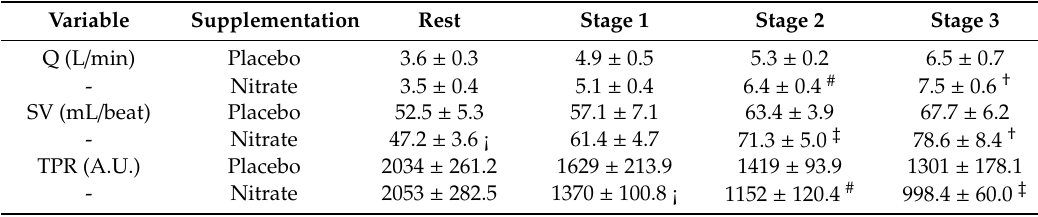
Figure 2. Individual and mean responses of plasma nitrate ( A ) and plasma nitrite ( B ). Black boxes are the nitrate treatment and the white circles represent placebo treatment. Abbreviations: NO 3- , nitrate, NO 2- , nitrite, * indicates significance at p < 0.05, ** indicates significance at p < 0.01. Table 2. Cardiac Function Response at Rest and During Exercise.